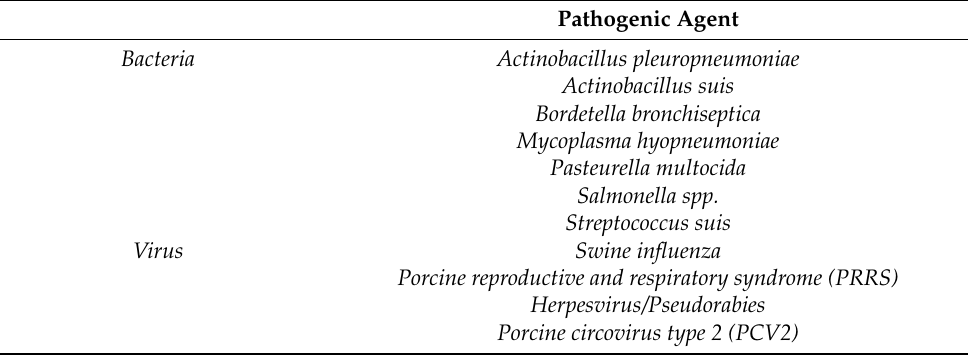
Table 1. Main pathogenic agents responsible for Porcine Respiratory Disease